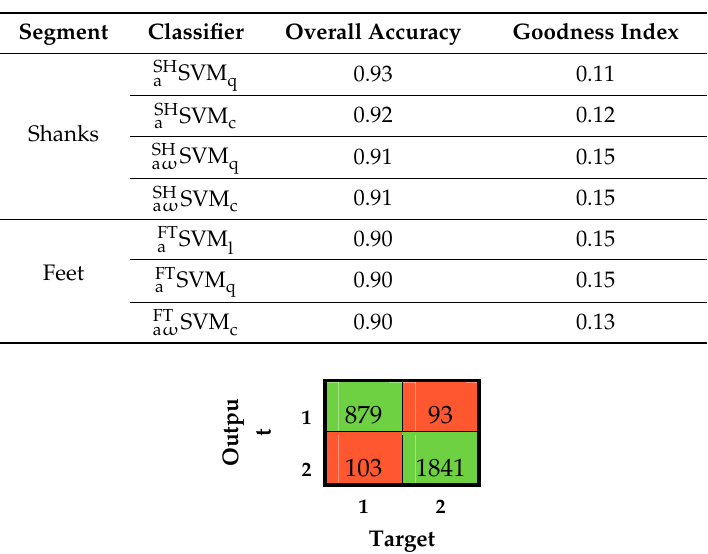
Table 7. Overall accuracy and goodness index related to the suitable classifiers that passed all previous selection criteria.